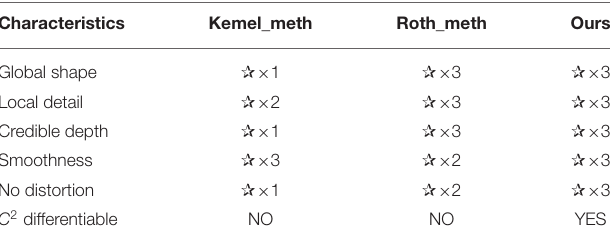
TABLE 2 | A characteristics summarization of three methods by rough rating with number of P